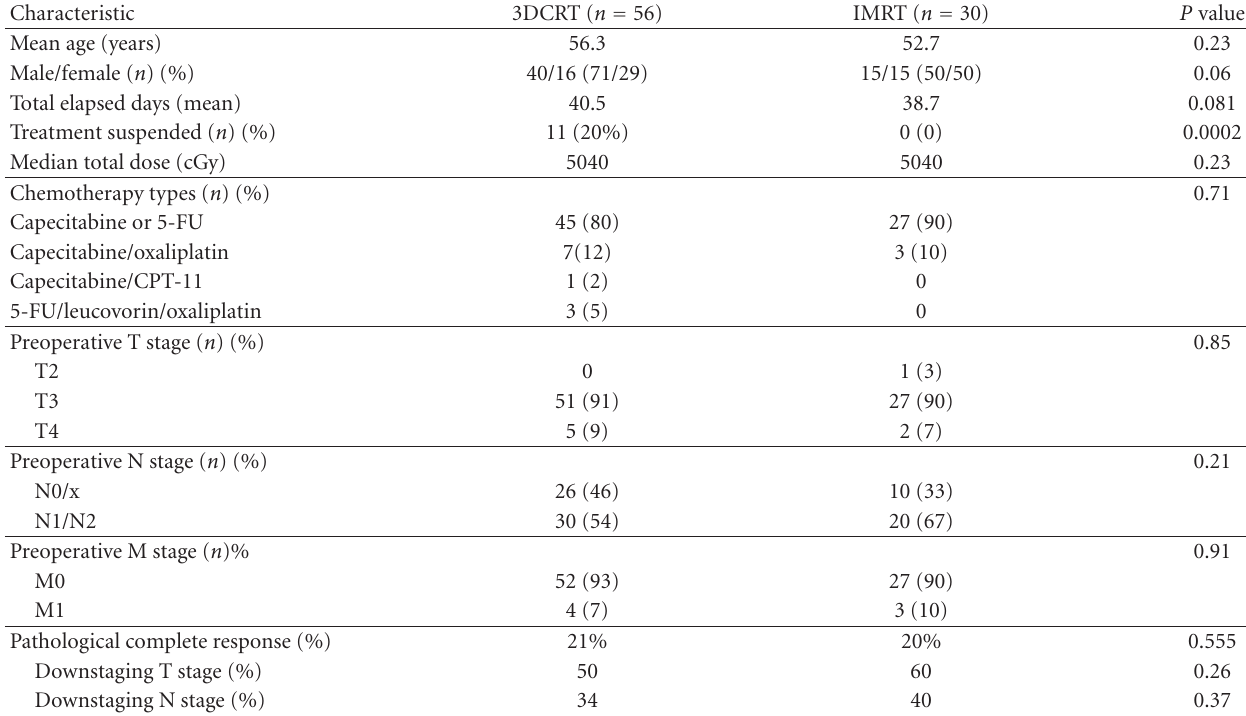
Table 1: Patient